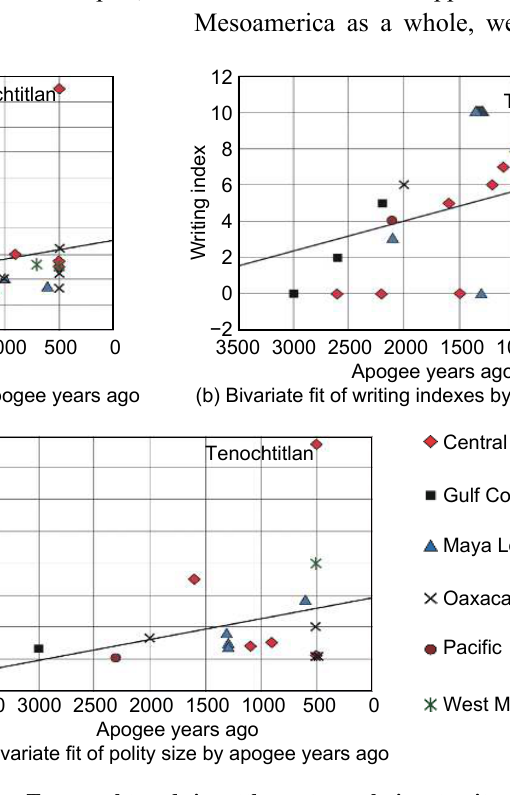
Fig. 3 Prehispanic Mesoamerica: Temporal trends in settlement population, territory, and